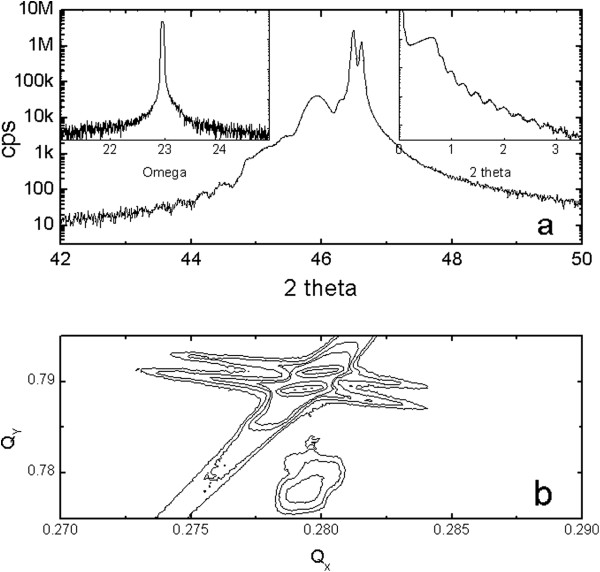
HRXRD results for the SrRuO3/SrTiO3 (001) substrate. (a) XRD θ to 2θ scan patterns. The left inset shows the rocking curve of the SrRuO3 (200)c peak. FWHM was as small as 0.057°. The right inset shows good oscillations at low angles due to the uniform thickness of about 38 nm. (b) X-ray reciprocal space mapping around the STO (114) plane showed well-developed peaks for SrRuO3 in the lower region and two strong substrate peaks in the upper region.